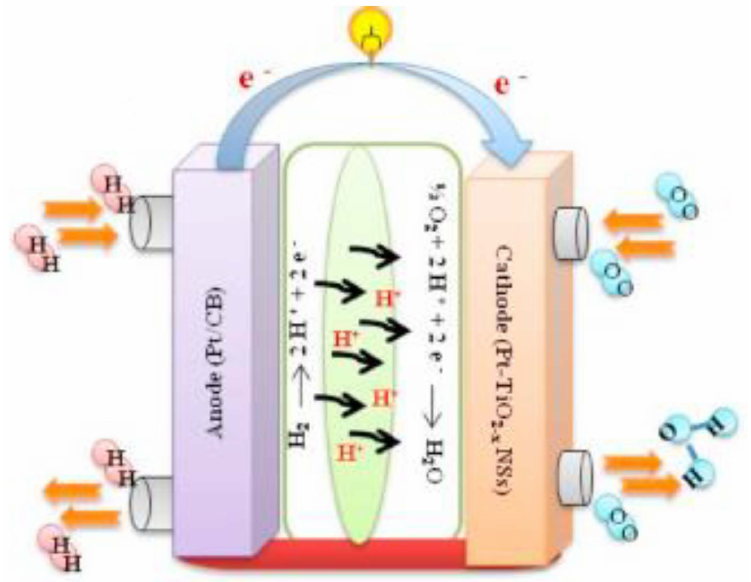
Figure 14. Schematic representation of a PEM fuel cell [140]. Copyright permission 2020,